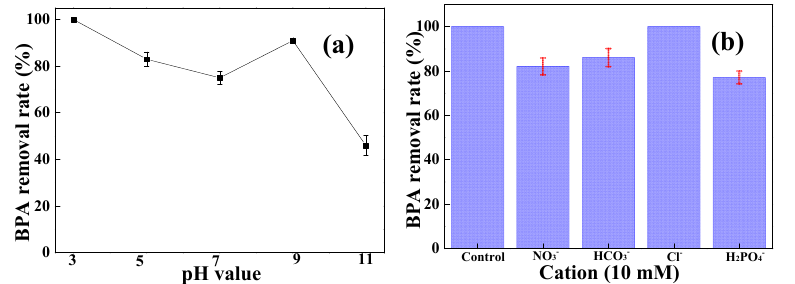
Figure 5. Impact of ( a ) pH value and ( b ) anions on the catalytic performance of ZFP ([BPA] 0 = 0.02 mM, flow rate = 5 mL/min).